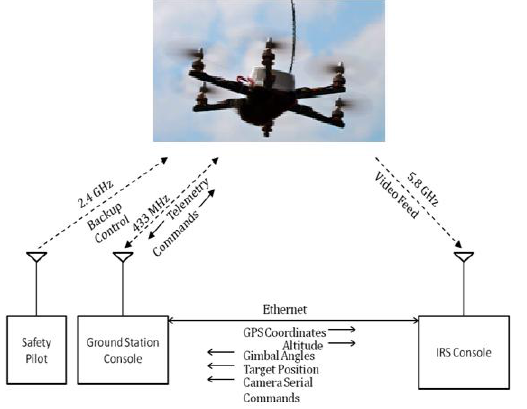
Figure 10. Wireless communication & Data